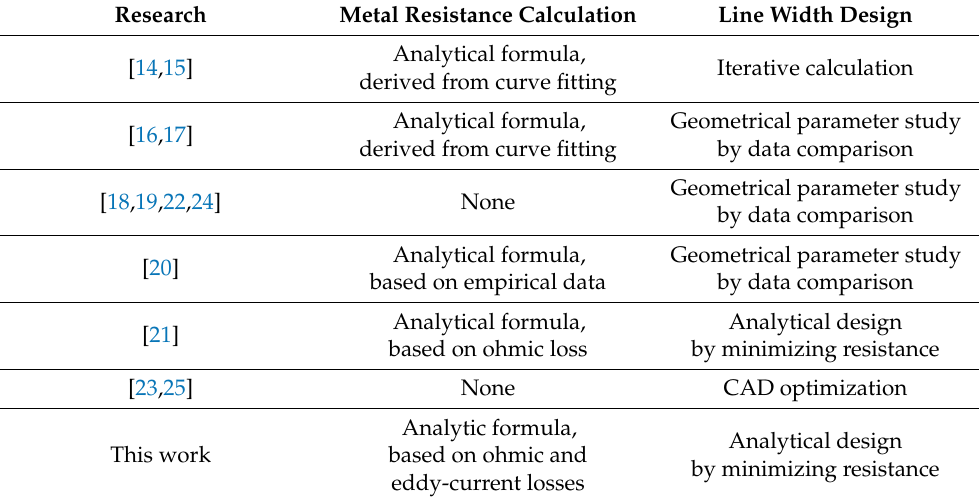
Table 1. A comparison of studies on the analysis of spiral inductors with variable metal line